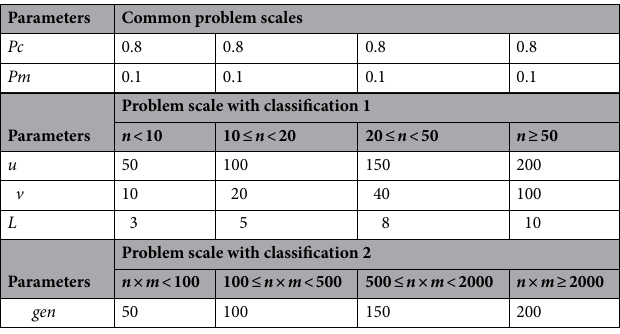
Table 1. Parameters